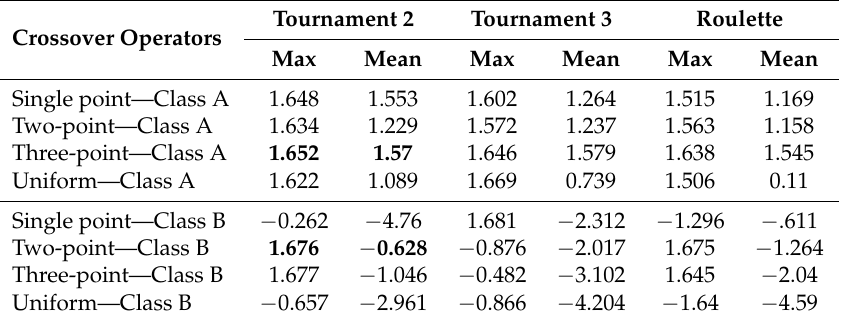
Table 3. Comparison of the fitness value obtained by the multiple selection and crossover genetic operators previously